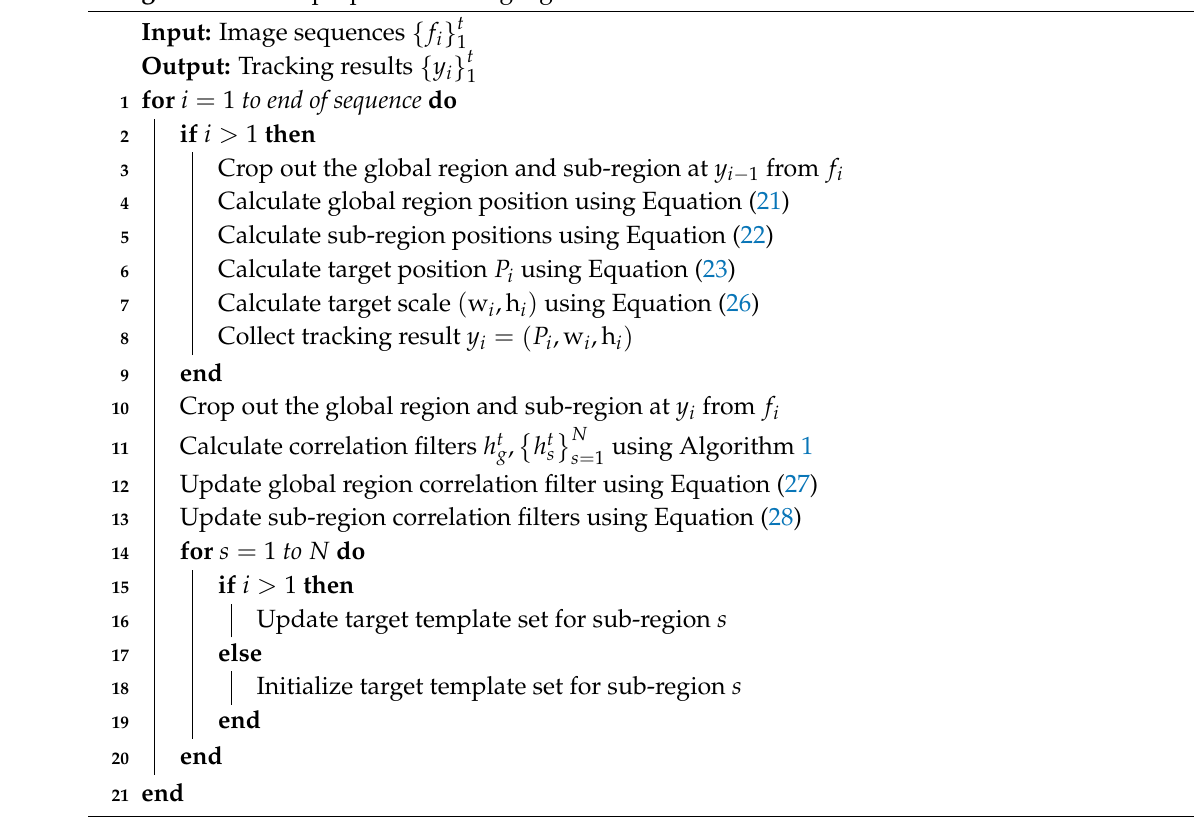
Algorithm 2: The proposed tracking